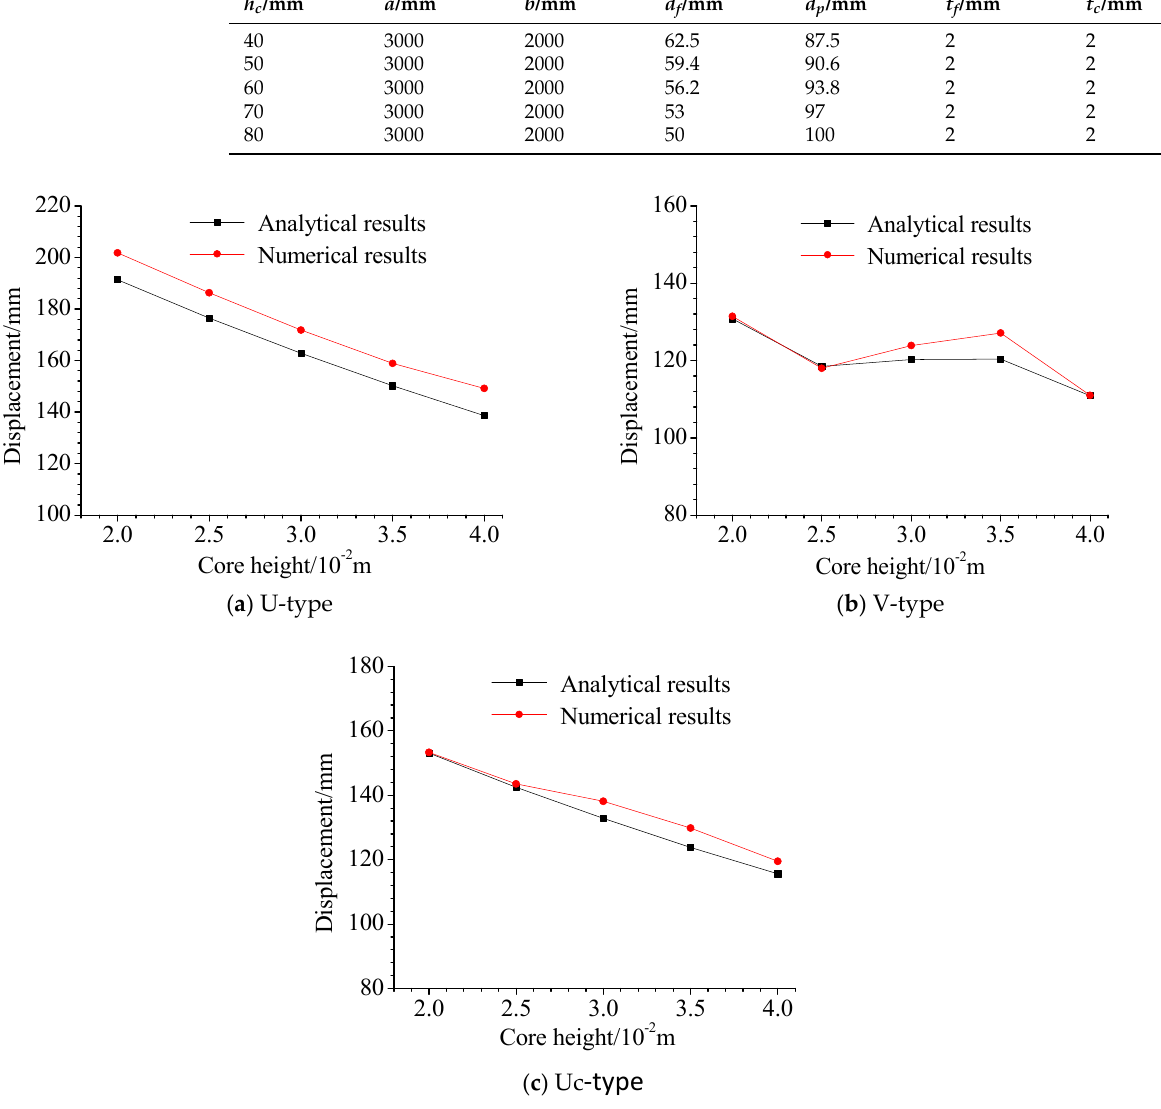
Figure 12. Displacement curves of the U ‐ , V ‐ , and Uc ‐ type sandwich structures with different core heights.